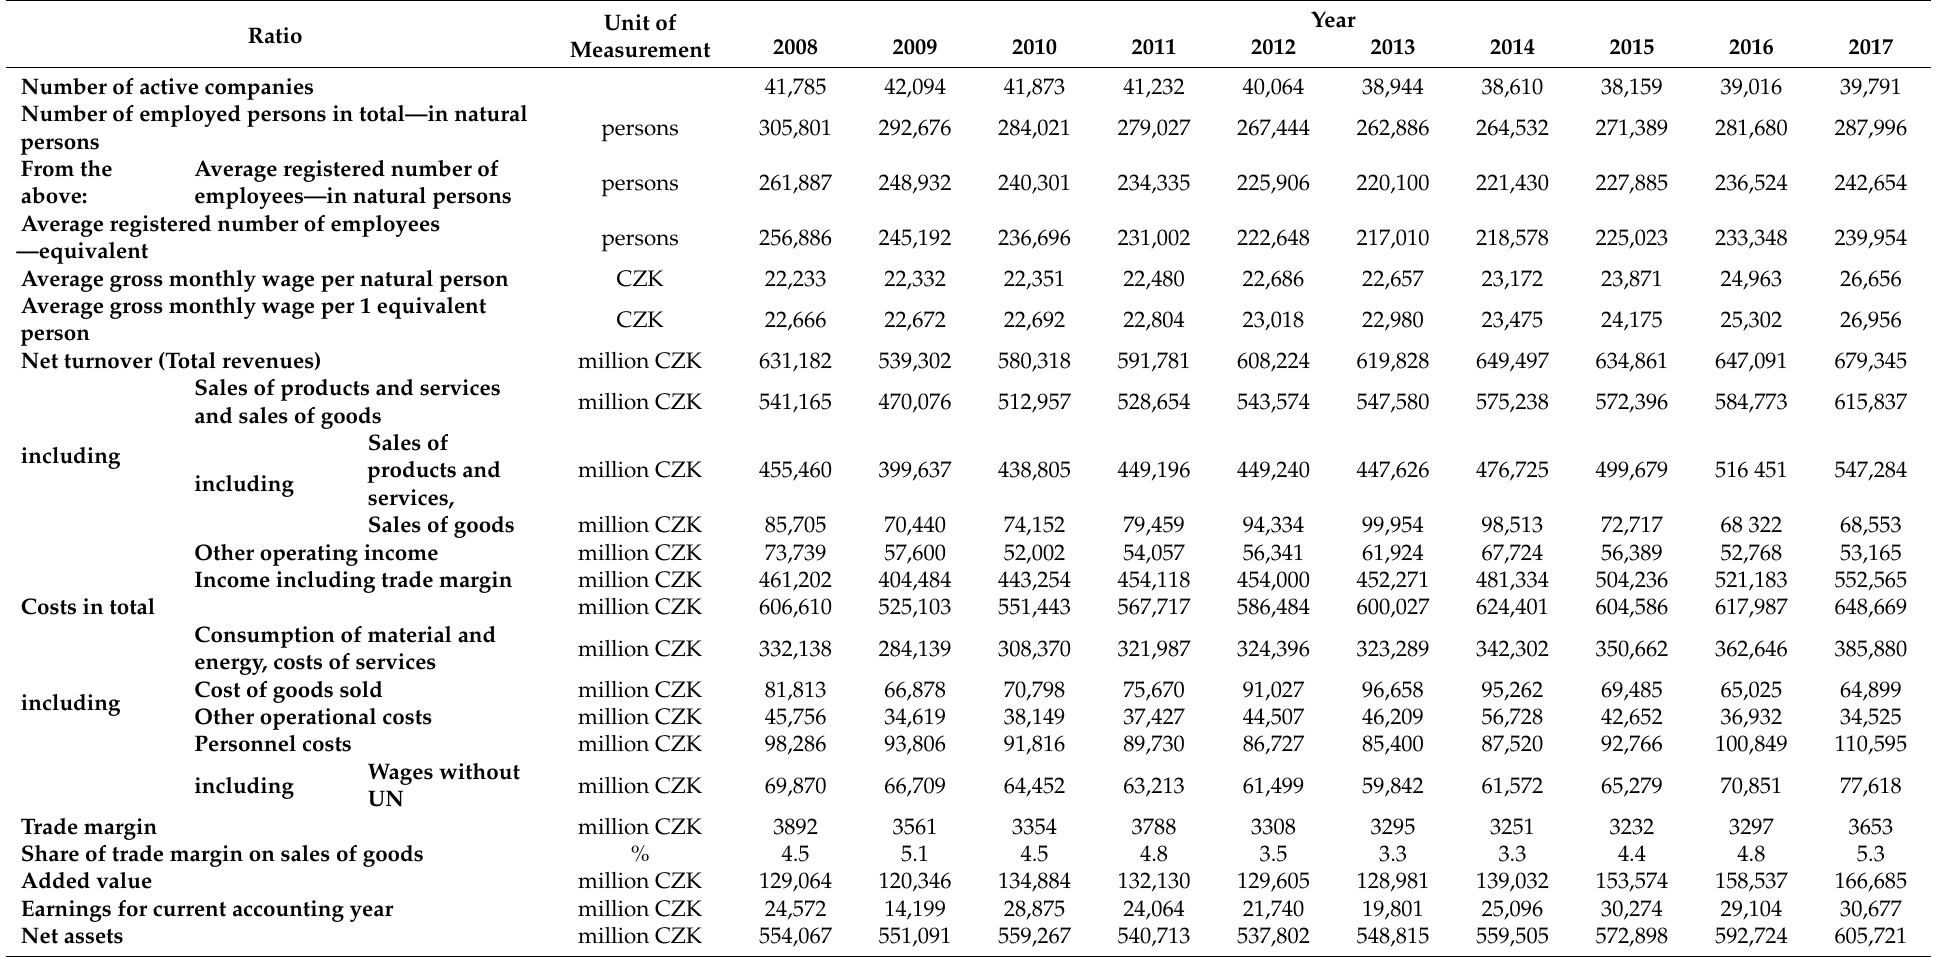
Table A1. Selected financial ratios (NACE classification), transport and